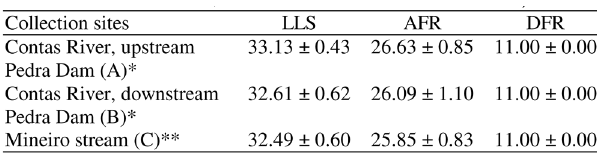
Table 2. Mean and standard deviation values for the number of lateral line scales (LLS), rays in the anal fin (AFR) and rays in the dorsal fin (DFR) of each population of Astyanax aff. bimaculatus (*Contas River Basin, ** Recôncavo Sul Basin).